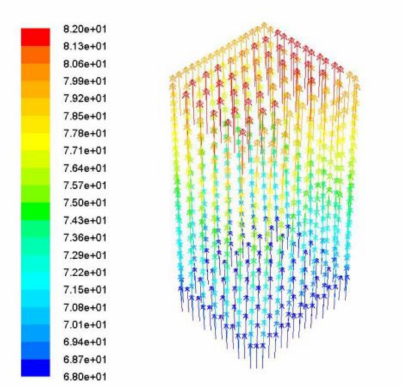
Figure 5. Simulation of the 1.8 × 10 2 × 1.8 × 10 2 mm